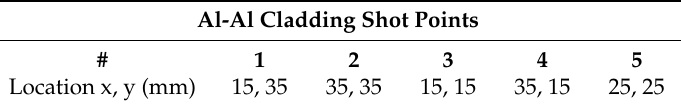
Table 1. Example of clad–clad shock locations.